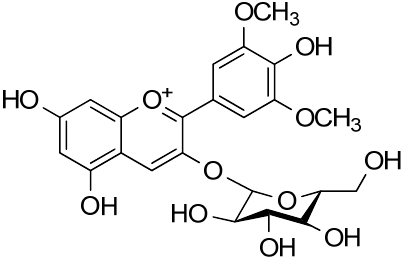
Figure 4. Structure of malvidin-3-glucoside or oenin in some sources.